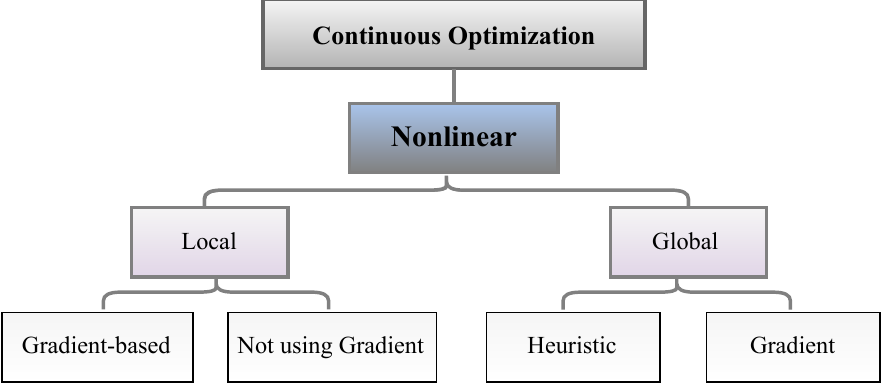
Figure 8. Classification of global and local optimization